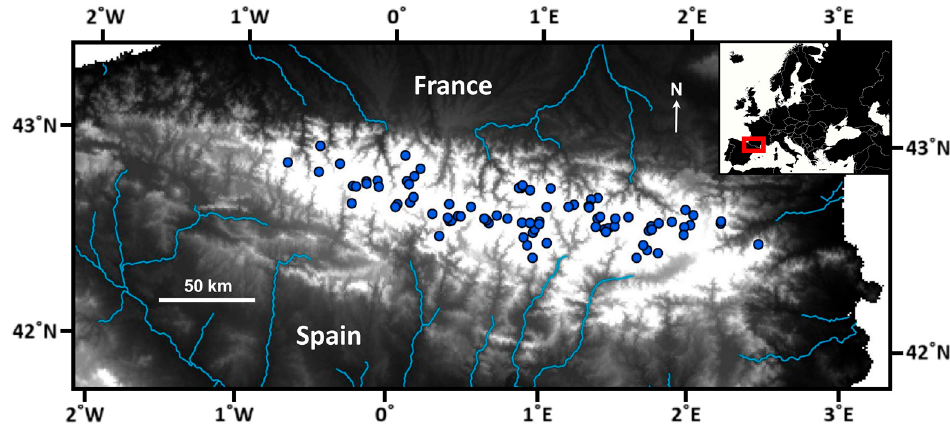
Figure 1. Distribution of the surveyed lakes across the Pyrenees. The main hydrological structure is highlighted. The white area, where the survey lakes are located, indicates elevations above 1600 m a.s.l. Maps are based on ArcGIS Desktop 9.3 and MapChart (h tt ps://www.mapchart.net/).